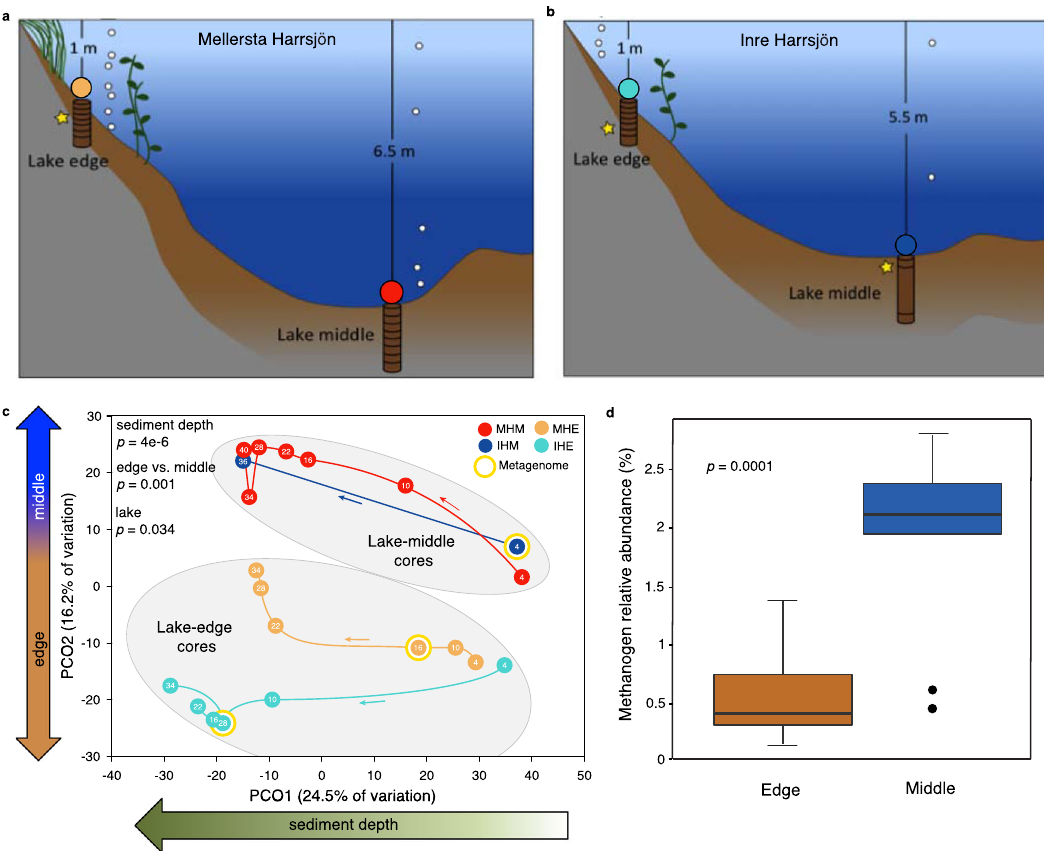
Fig. 2 Lake sediment bacteria and archaea in two post-glacial lakes. a , b Schematic overview of lakes and cores collected for DNA sequencing analyses, with core subsections indicated by horizontal lines. Cores in each lake are referred to as Lake edge or Lake middle, with overlying water depth as indicated, and the four colored circles are used to distinguish each core and/or lake location throughout the fi gures. Yellow stars indicate cores and depths targeted for shotgun metagenomics. c Principal coordinates analysis (PCoA) of microbial community composition across samples (each core subsection, n = 21), based on 16S rRNA gene amplicon abundances of microbial operational taxonomic units (OTUs); circles represent samples, and samples in closer proximity have more similar microbial community composition. Thin arrows along colored lines indicate increasing depth within each core. p -Values from one-way PERMANOVA indicate how signi fi cantly microbial community composition differed according to the indicated categorical variable (signi fi cant if p < 0.05). d Percent relative abundance of OTUs identi fi ed as methanogens in 16S rRNA gene amplicon data in lake edges compared to lake middles ( p - value from two-tailed Student ’ s t -test, signi fi cant if p < 0.05), n = 21 biologically independent samples. Lines in boxes depict the median, boxes indicate 75th percentile, whiskers 95th percentile, and points are